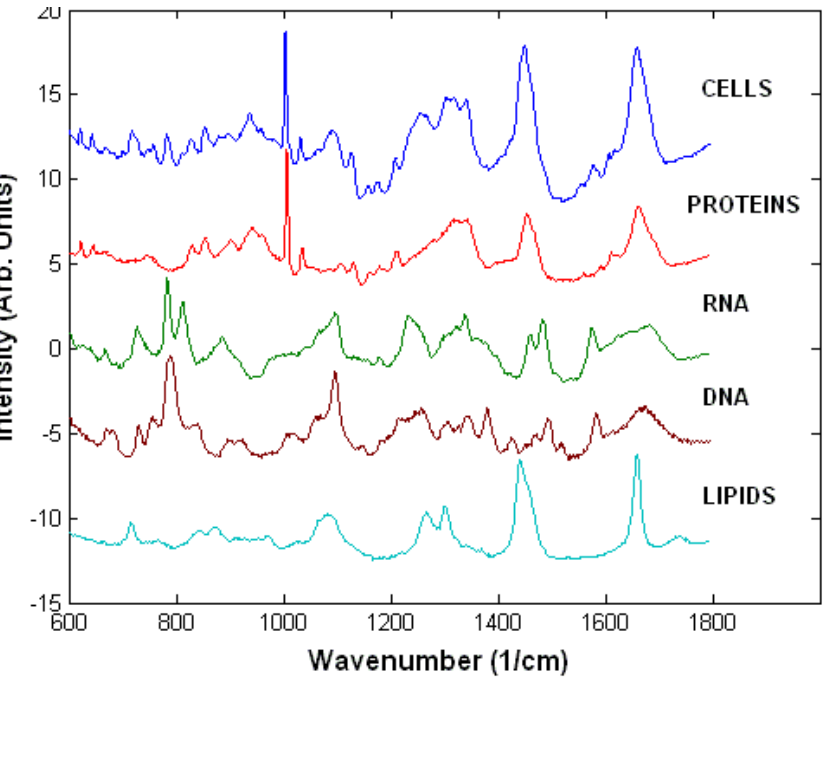
Figure 2 . Typical Raman spectrum of a cell and of main biopolymers found in